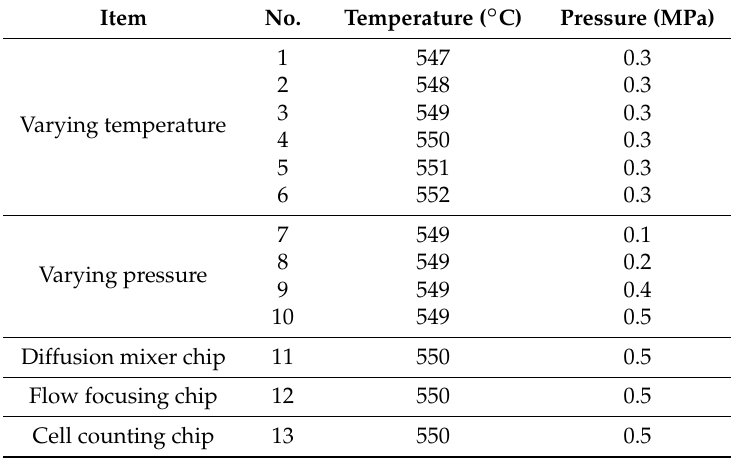
Table 3. Details of the parameters in the glass molding process